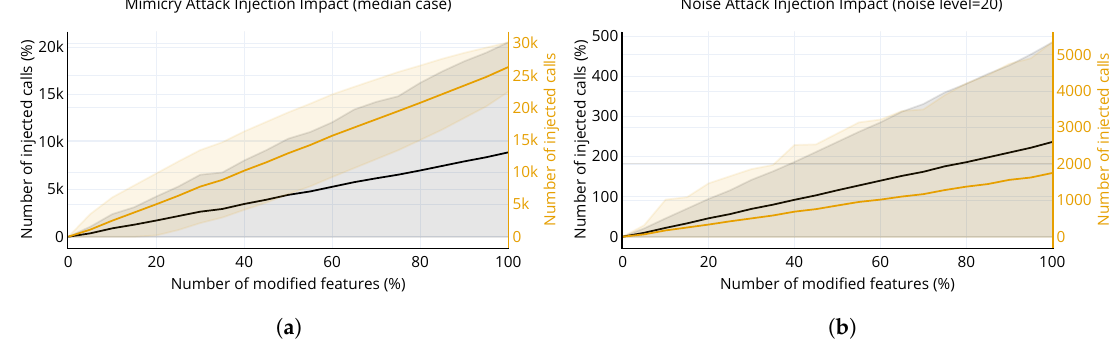
Figure 10. Average impact on the number of calls for mimicry ( a ) and noise ( b ) attacks. The standard deviation is also reported in translucent